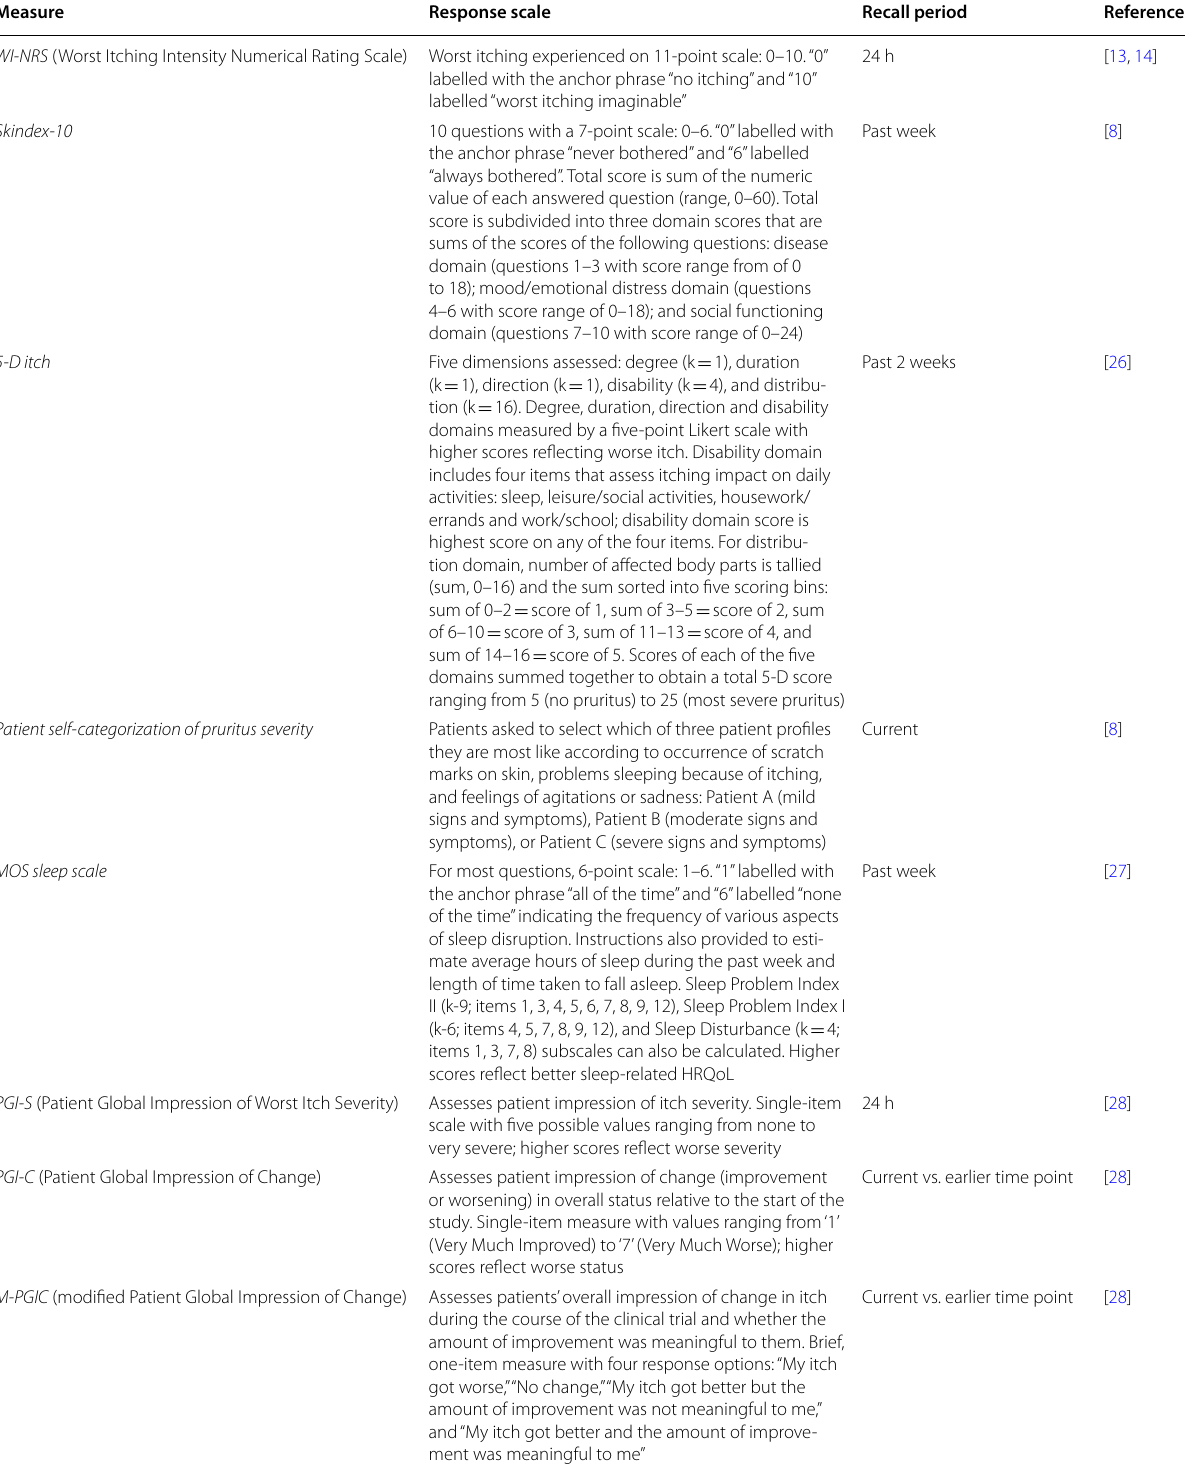
Table 1 Patient-reported outcome